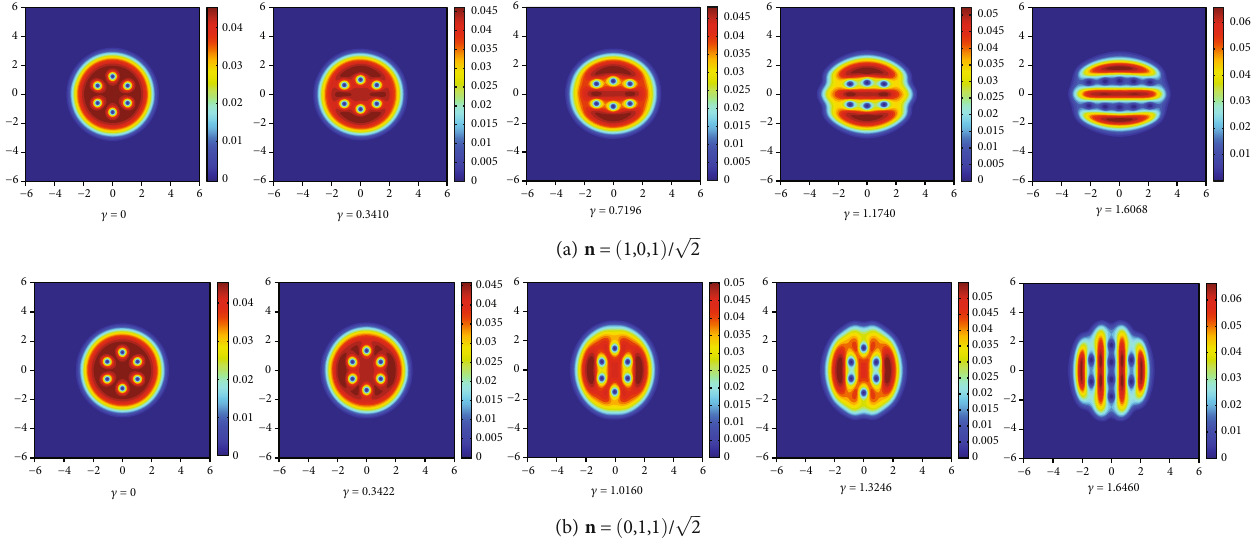
ð x , y Þ = ð 1 : 003 x 2 + 0 : 997 y 2 Þ /2 + ð 1 : 003 x 2 + 0 : 997 y 2 Þ 2 /4 , 2